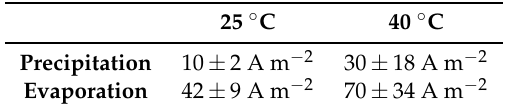
Table 8. The operating current density of RED (see Equation (11)).